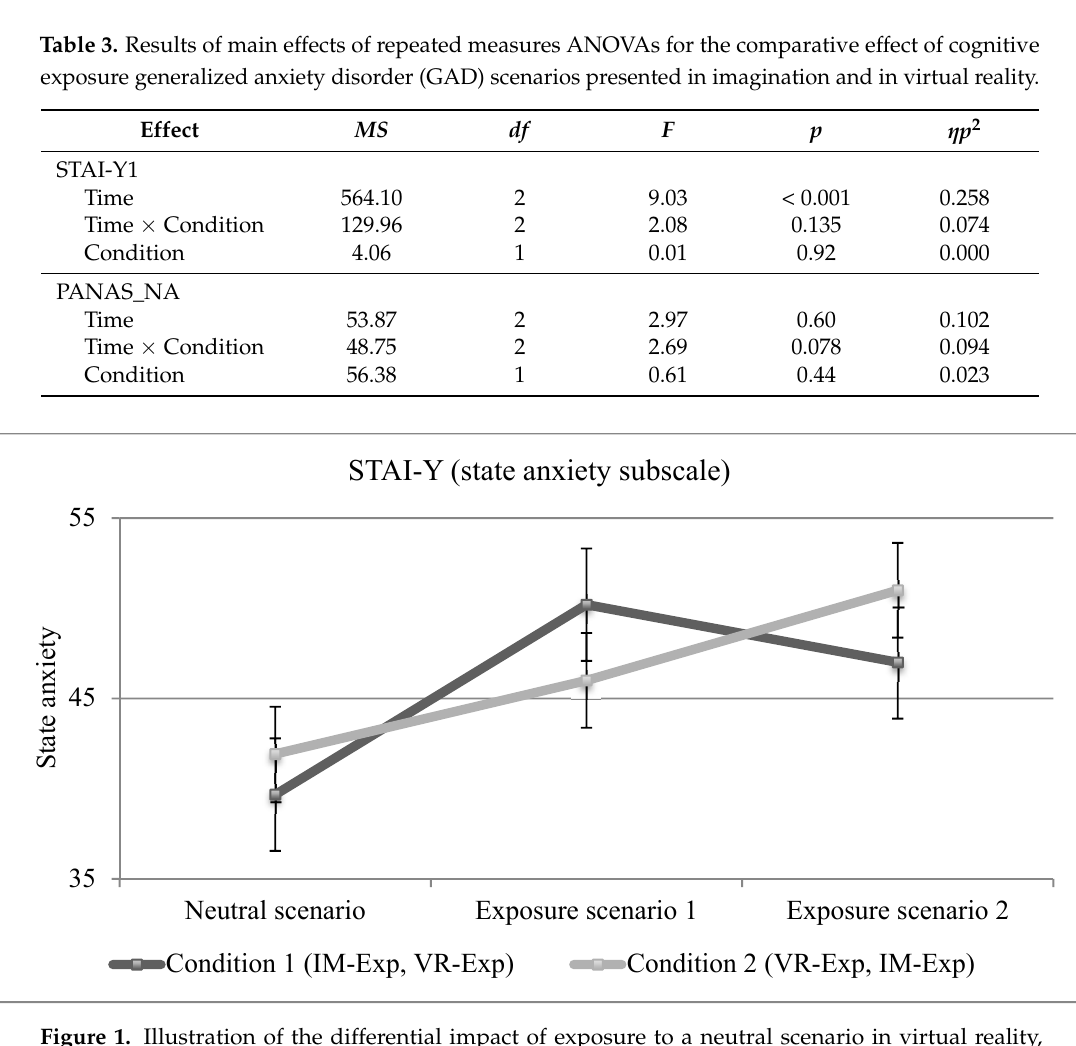
Table 3. Results of main effects of repeated measures ANOVAs for the comparative effect of cognitive exposure generalized anxiety disorder (GAD) scenarios presented in imagination and in virtual reality.